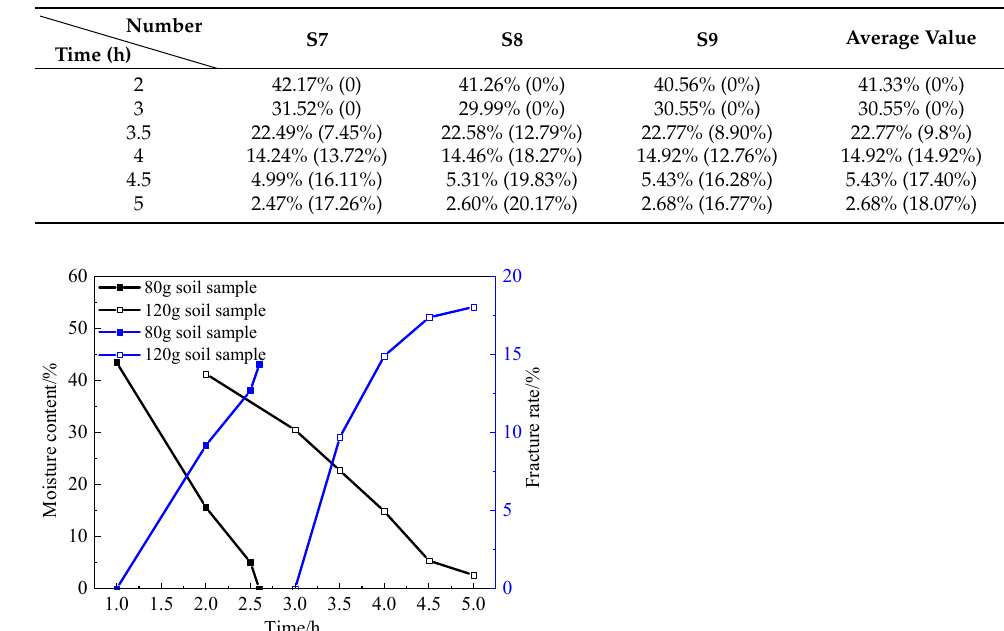
Figure 11. Soil sample wet and dry cycle binarized fissure diagram. ( a ) The fissure morphology of